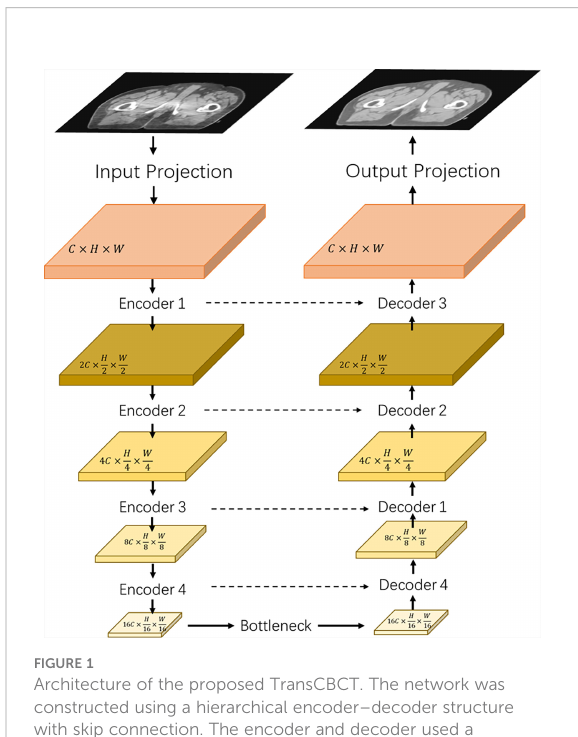
FIGURE 1 Architecture of the proposed TransCBCT. The network was constructed using a hierarchical encoder – decoder structure with skip connection. The encoder and decoder used a transformer block to construct a hierarchical structure, which was ef fi cient to extract features and recover the image structures and